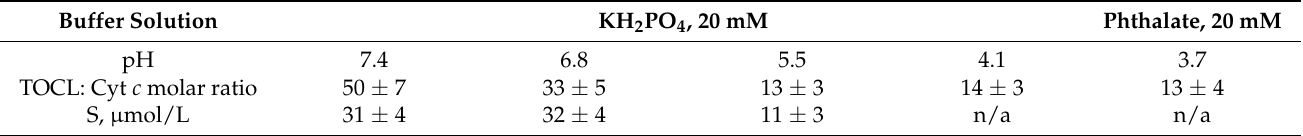
Table 1. Molecular solubility, S , and TOCL:Cyt c molar ratios in the complex at different pH values in an aqueous medium obtained by spectrophotometry; p = 0.95, n = 3.